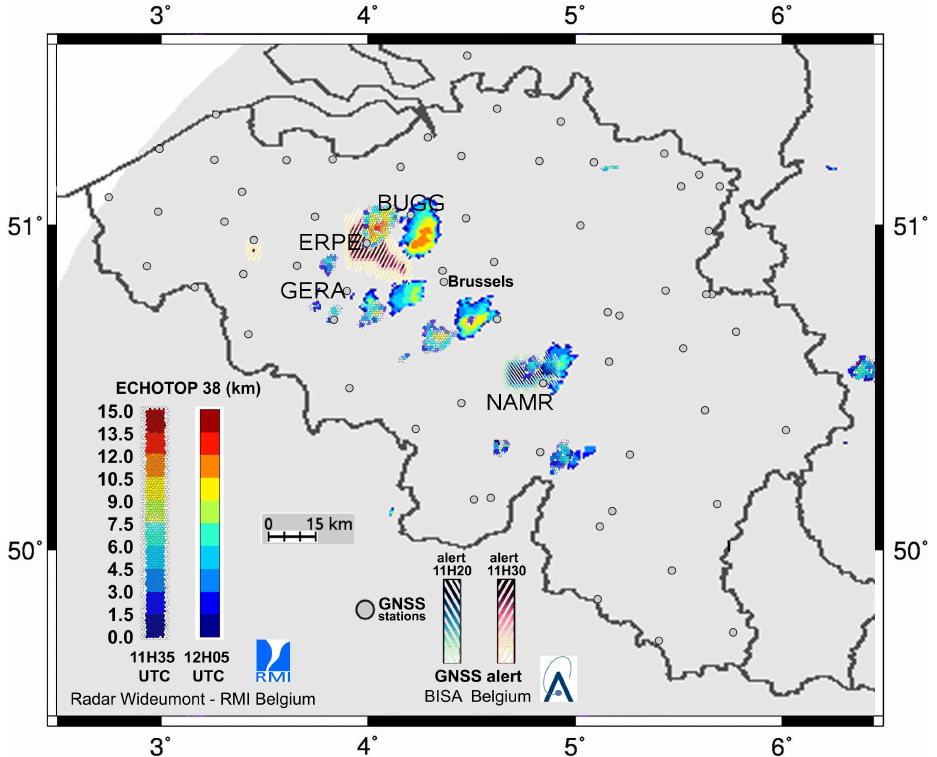
Figure 18. GNSS H2O alerts (11:20 and 11:30UTC) and radar echoes top (altitude of the highest 38dBZ radar echo) at 11:35 and 12:05UTC, on 29 June